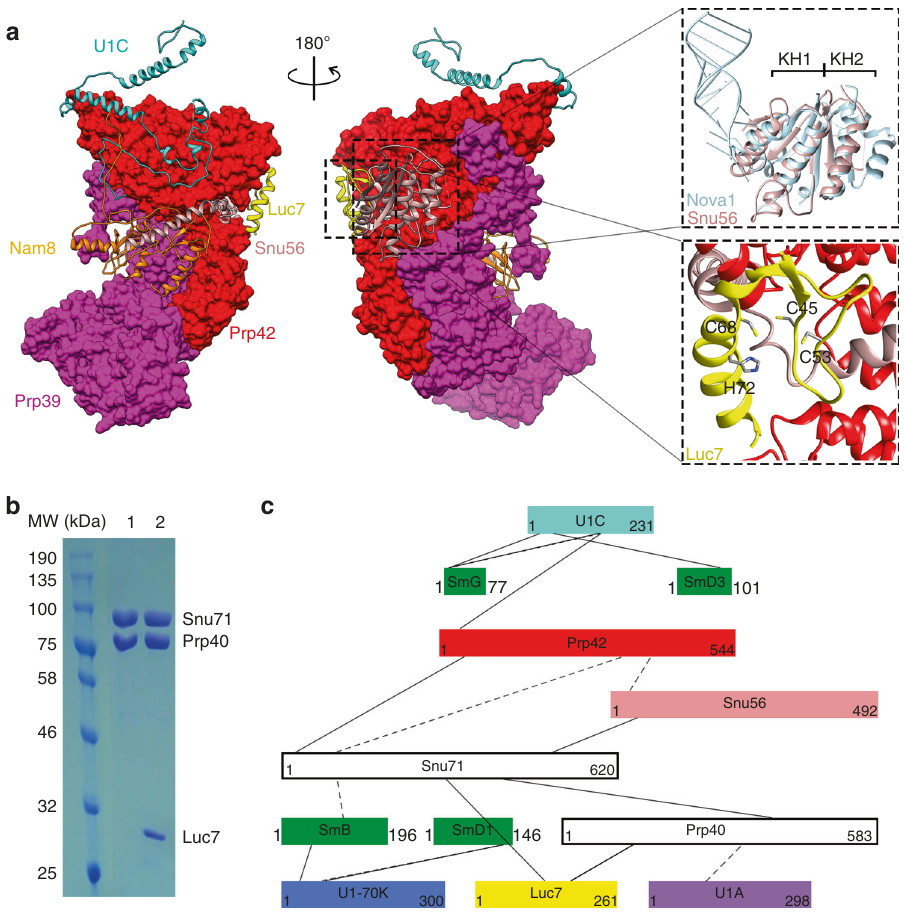
Fig. 5 Structures and interactions of yeast auxiliary proteins Nam8, Snu56, and Luc7. a The relative positions of Nam8, Snu56, and Luc7 with respect to Prp42, Prp39, and U1C. Snu56 has two KH-like domains that can be superimposed very well with the two KH domains in Nova1 (PDB ID 2 ANR). Luc7 contains a pseudo zinc- fi nger and it interacts with Prp42 and Snu56. b Snu71 + Prp40 (lane 1) or Snu71 + Prp40 + Luc7 (lane 2) can be co-expressed in yeast and puri fi ed as a complex using the protein A-tag on Prp40. c Mass spectrometry analyses of puri fi ed U1 snRNP crosslinked with BS3 reveal crosslinked peptides between proteins. Solid lines represent con fi dently identi fi ed crosslinks with a false discovery rate of less than 5%. Dashed lines represent crosslinks identi fi ed with a false discovery rate of 5 – 20% and are considered probable. Only inter-molecular crosslinks are shown for